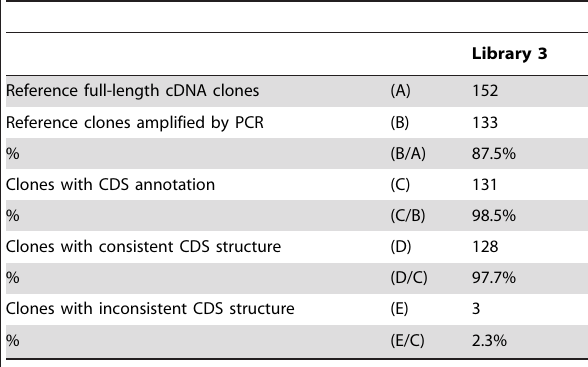
Table 6. Assembly statistics and accuracy evaluation for Toxoplasma gondii full-length cDNA